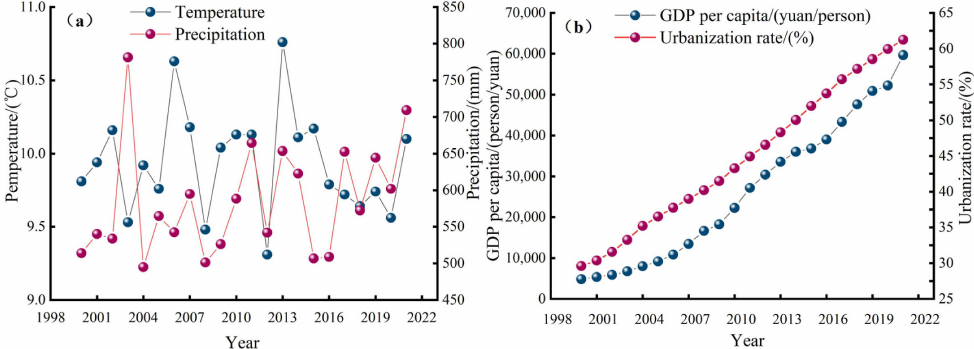
Figure 7. Annual per capita GDP, urbanization development change ( a ) and annual average climate change ( b ), in the Weihe River